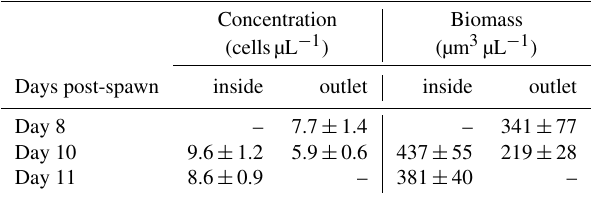
Table 2. Larval food concentration sampled from inside the tank and at the outlet. Values are means and standard deviation ( n =